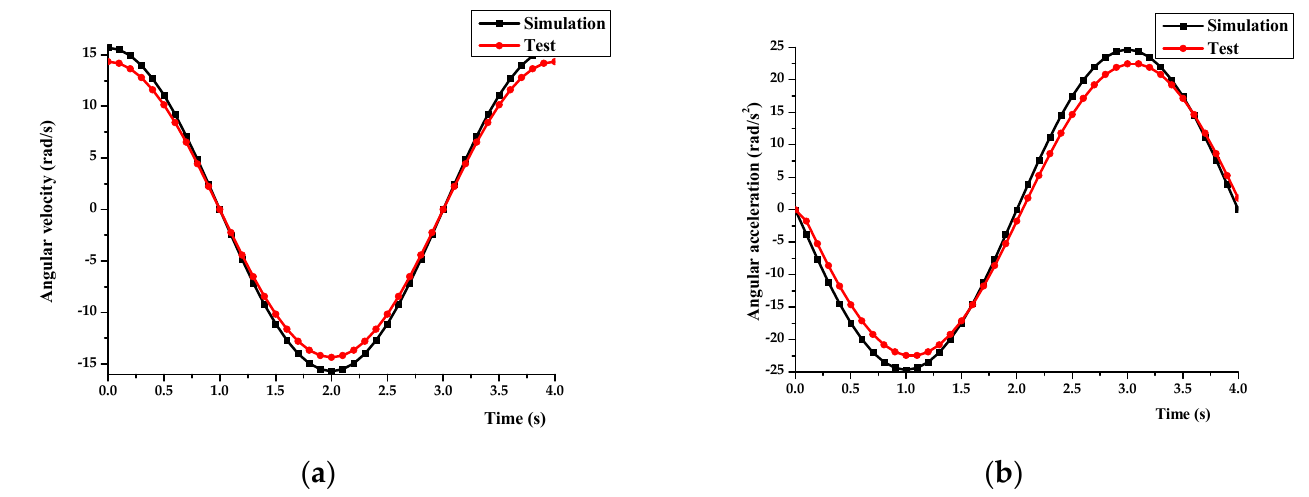
Figure 22. ( a ) Angular velocity ( b ) Angular acceleration comparison chart of the pitch motion. To sum up, the velocity error during the roll motion was about 7.41%, and the acceler- ation error was about 7.58%. Thus, the velocity error during the pitch motion was 8.6%, and the acceleration error was about 8.96%. Obviously, the overall trend of those motions was in line with the actual measurement. The small error in the value could be judged as the difference from the load above. This part was to verify the angle error between the motor output angle simulation and the actual motor output. In the first place, the motion sensor was installed on the crank. Then, the motor trajectory measurement of the platform roll, and pitch motion was carried out. Among them, the roll and pitch motion were to let the upper platform to obtain the actual crank output angle, the average value of the trajectory error, and the standard deviation of the measurement. The angle trajectory test of the platform is shown in Figure 23.